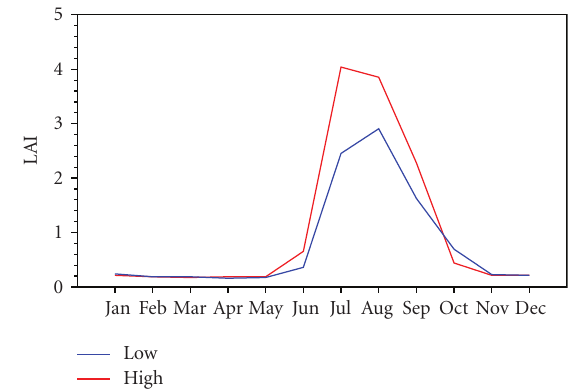
Figure 5: The seasonal variations of the low (blue) and high (red) LAIs. The high LAI is the average over 1983–1985, while the low LAI is the average over